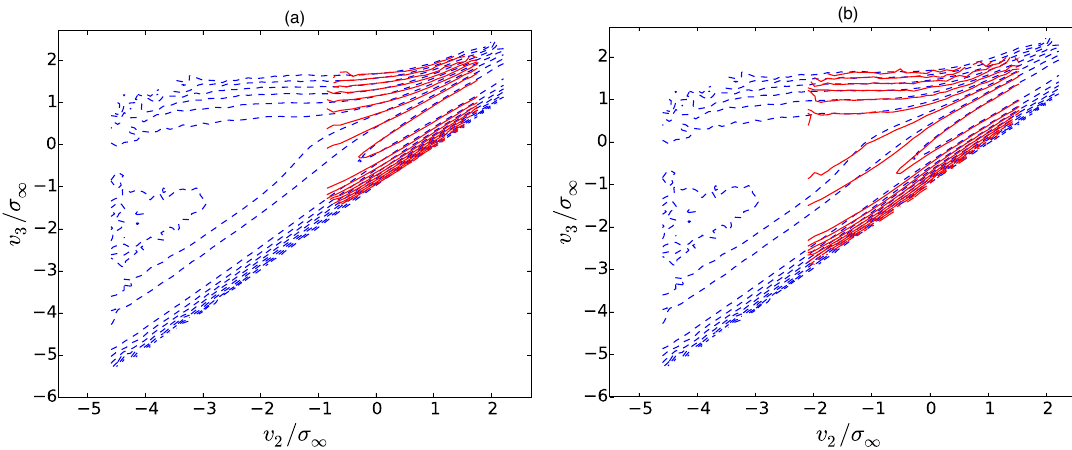
Figure 6. ( a ) examination of the Markov property (28) from DNS of Burgers turbulence for r = 2 λ and v 1 = 0 via a logarithmic contour plot. The dashed blue contour lines correspond to p ( v 3 , L /2 − ∆ r | v ) whereas the red lines correspond to p ( v − ∆ r | v + ∆ r ) . The Markov 2 , L /2 3 , L /2 2 , L /2; v 1 , L /2 property is fulfilled only approximately. Although the contours exhibit an almost identical shape, they seem to be slightly displaced. The shape of the transition PDF (blue) can be reproduced for the most part by the theoretical predictions (31); ( b ) same as in ( a ), but for v 1 = − σ ∞ . A broader part of the blue dashed lines that belong to p ( v 3 , L /2 − ∆ r | v 2 , L /2 ) can be covered in comparison to ( a ). Event though the red contour lines indicate insufficient statistics in the boundary regions, the Markov property has not deteriorated in comparison to ( a ).